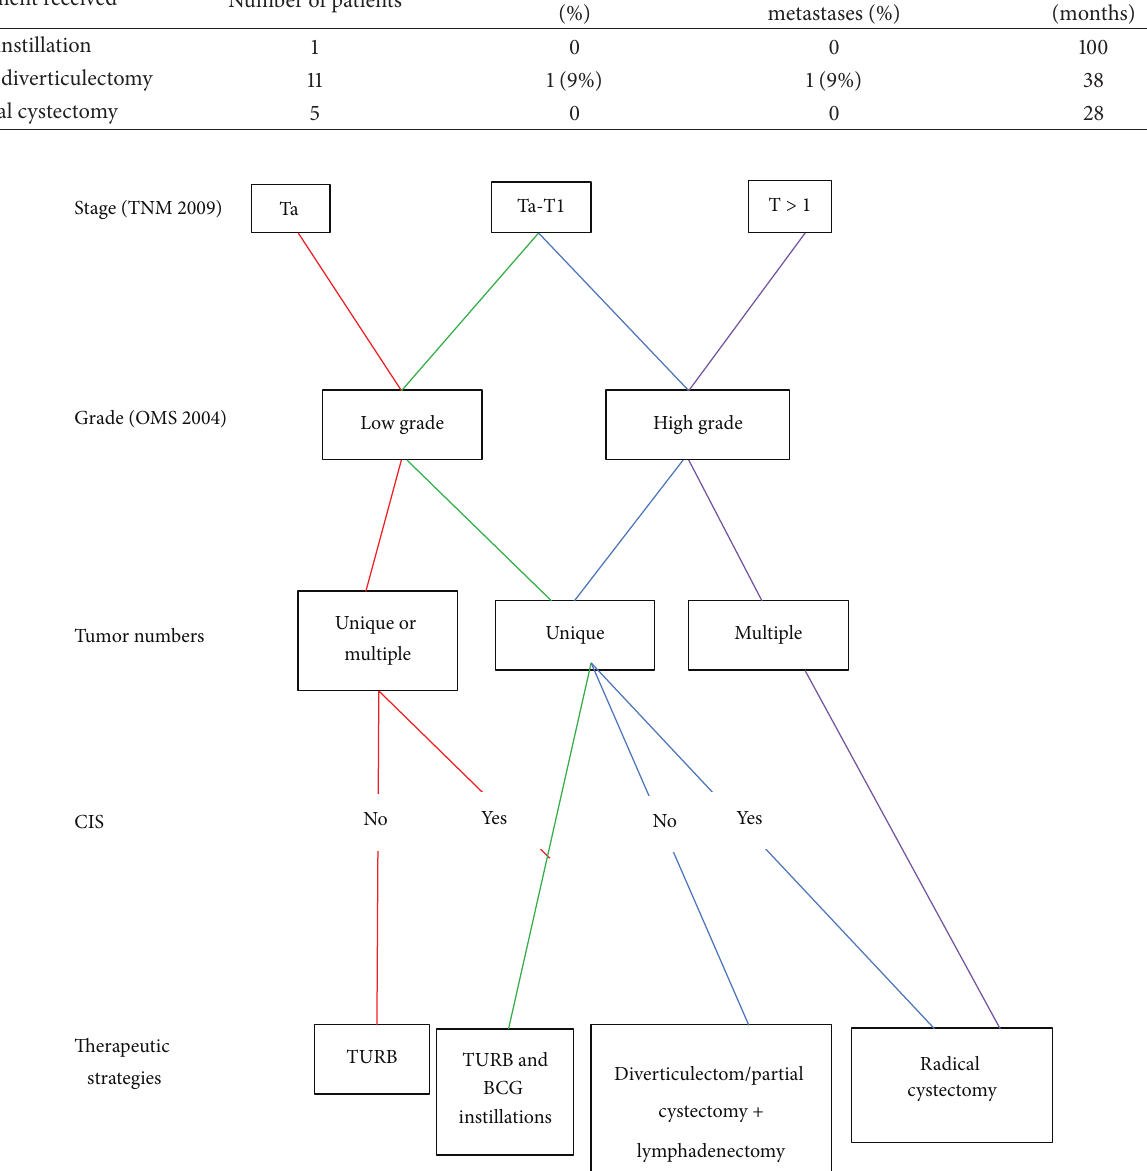
In their study, Baniel and Vishna reviewed the clin- ical outcome of 8 patients with primary intradiverticular transitional cell carcinoma who were treated conservatively (TURB, diverticulectomy, or partial cystectomy followed with either Bacille Calmette-Guerin (BCG) instillations, Thiotepa instillations, or postoperative irradiation). After a mean follow-up duration of 6 years, six of eight patients were disease-free. Similar results were observed in our study where 81.81% of patients treated conservatively were disease-free after a median follow-up of 38 months